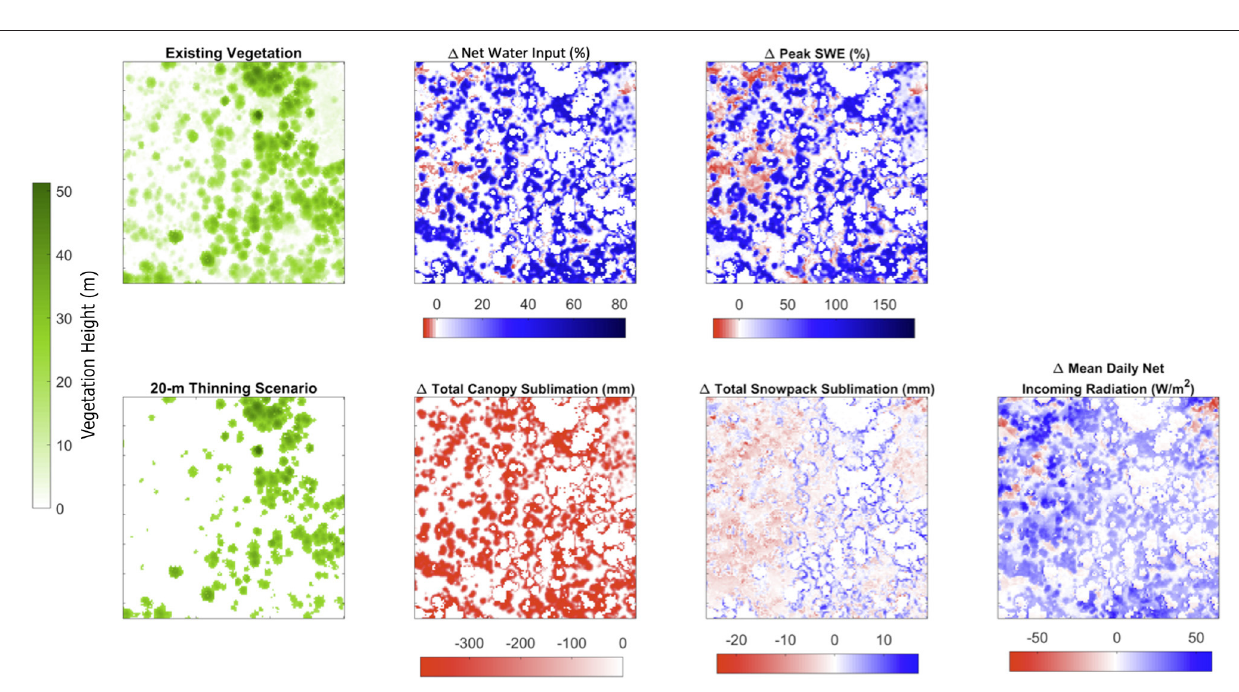
FIGURE 4 | Subdomain (150 × 150m; see red box in Figure 1 ) example at 1-m resolution for the 20-m thinning scenario in the WY16. Left panels show pre- and post-thinning vegetation height, and the remaining panels show changes (thinning scenario—control run) in net water input, peak SWE, total canopy sublimation, total snowpack sublimation, and average incoming solar radiation during the snow covered season.